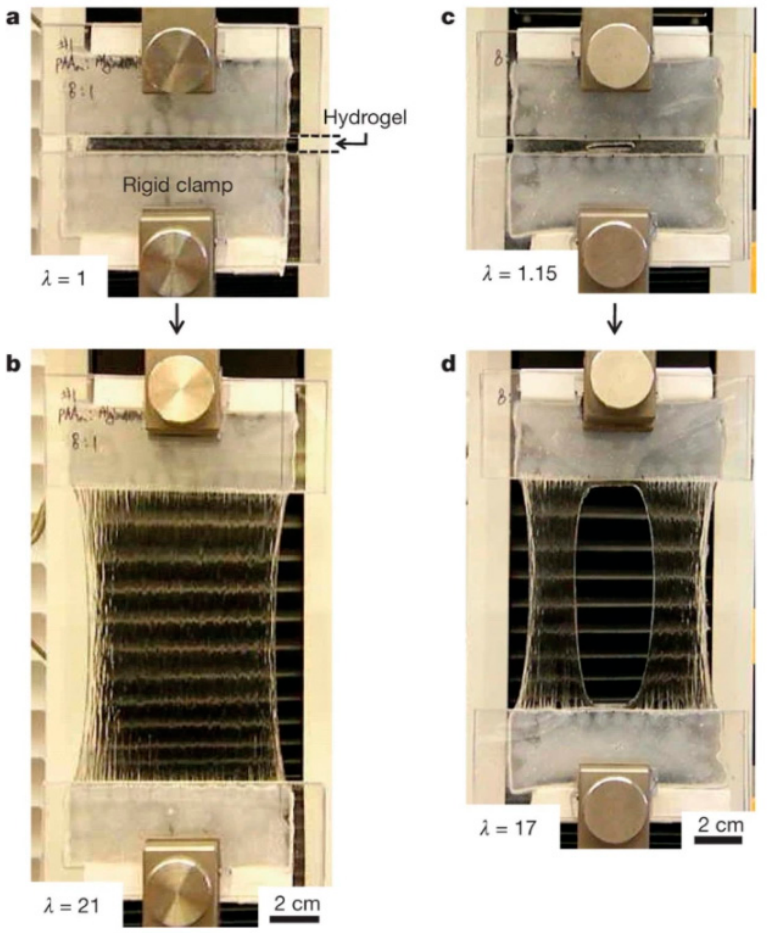
Figure 2. ( a ) The non-perturbed hydrogel between two rigid clamps. ( b ) The gel was stretched 21 times its initial length in a tensile machine. ( c ) The gel was damaged by forming razor blade notch. ( d ) Due to the damage, the stretching was 17 times the initial length instead, but still significant. Reproduced from [8] with permission.